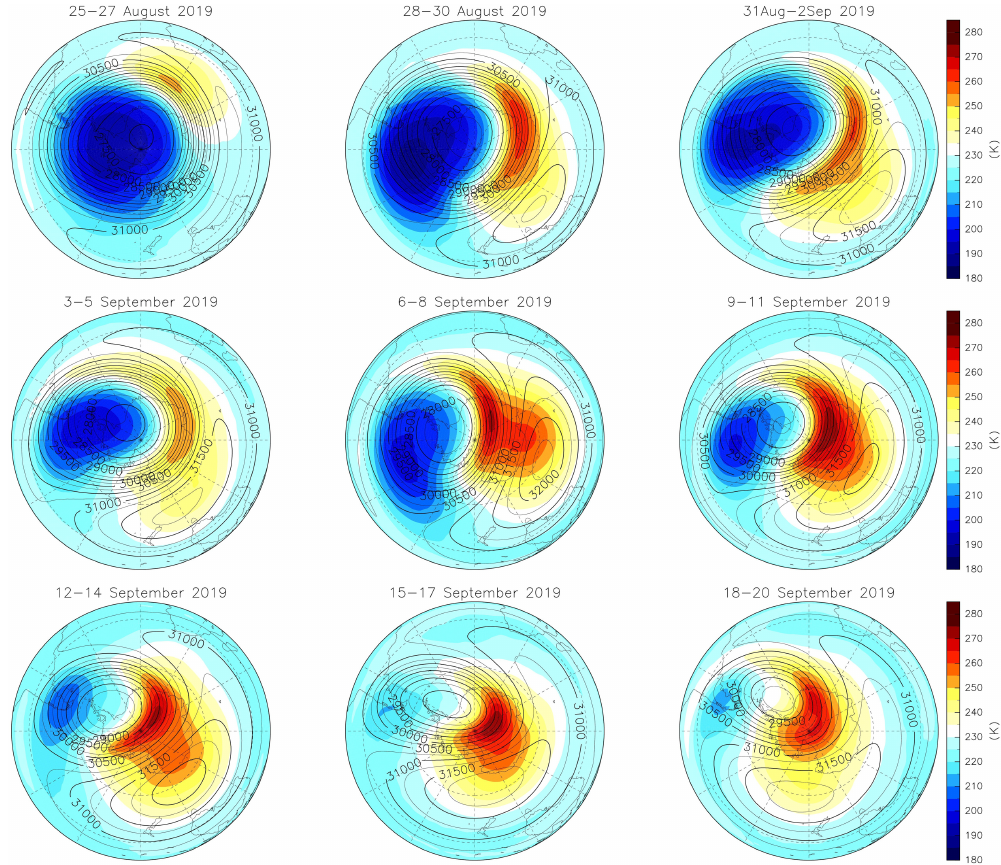
Figure 2. Polar stereographic map of temperatures (K) (color shading) and geopotential heights (m) (contours) in the Southern Hemisphere at 10hPa for successive 3d mean from 25 August to 20 September 2019. Contour intervals are 250m.